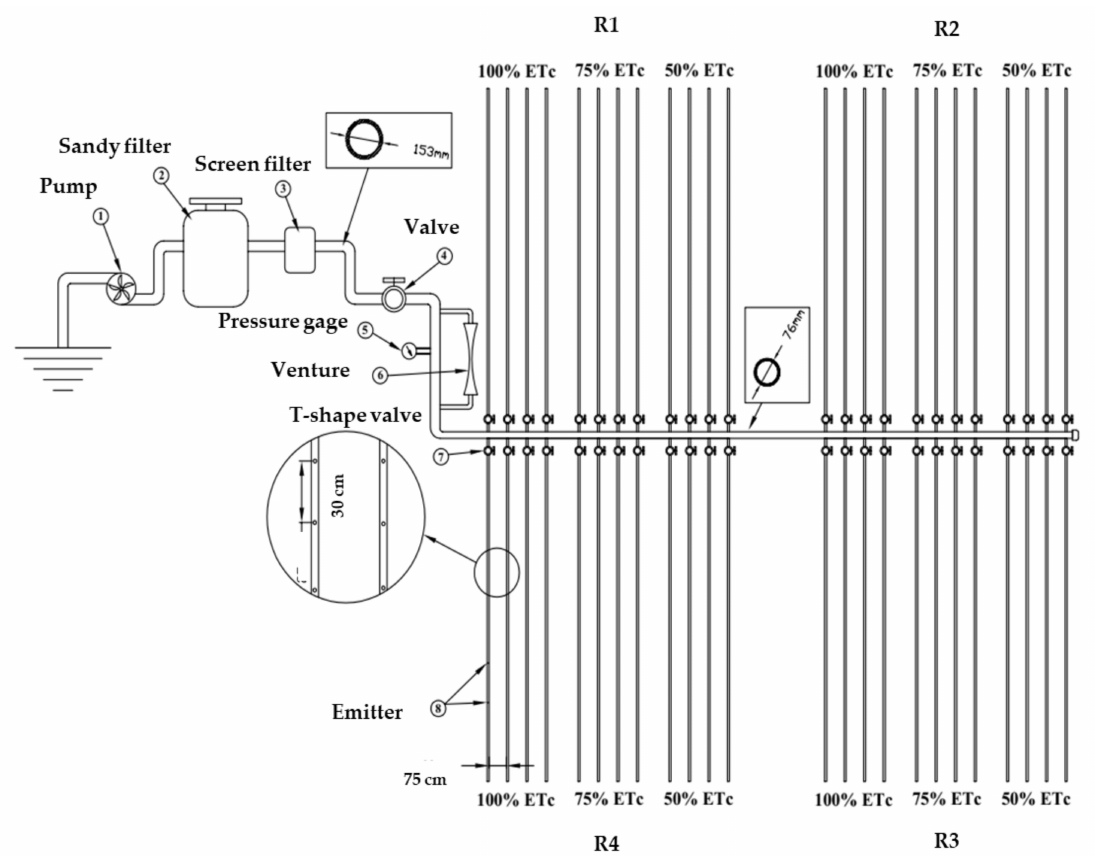
Figure 1. Schematic diagram of the experimental layout that includes three irrigation regimes and four replications showing locations of irrigation regimes and